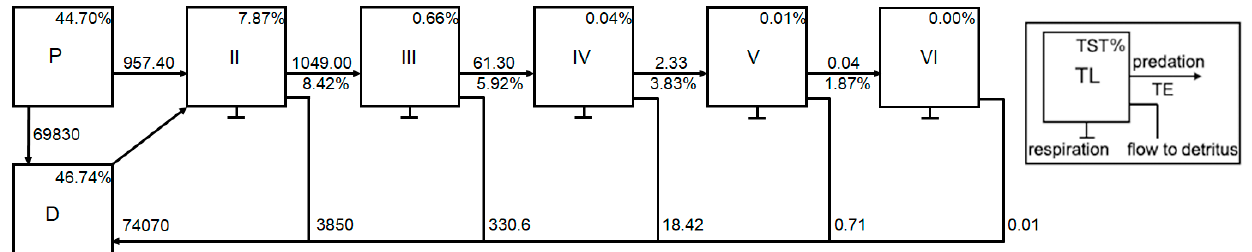
Figure 2. Trophic flow diagram of the Dongsha seagrass bed model. The area of each compartment represents the pro- portion of the total biomass of the model contained by the compartment. The line between each compartment represents the trophic relationship between them. Line width represents the relative flux between compartments. The numerical legend for compartments is: 1. pelagic sharks; 2. lemon sharks; 3. ray; 4. piscivorous fish; 5. large carnivorous fish; 6. small carnivorous fish; 7. omnivorous fish; 8. detritivorous fish; 9. seagrass herbivorous fish; 10. algae herbivorous fish; 11. hawksbill turtles; 12. green turtles; 13. cephalopods; 14. urchins; 15. carnivorous invertebrates; 16. omnivorous inverte- algae; 23. seagrasses; and 24. detritus.